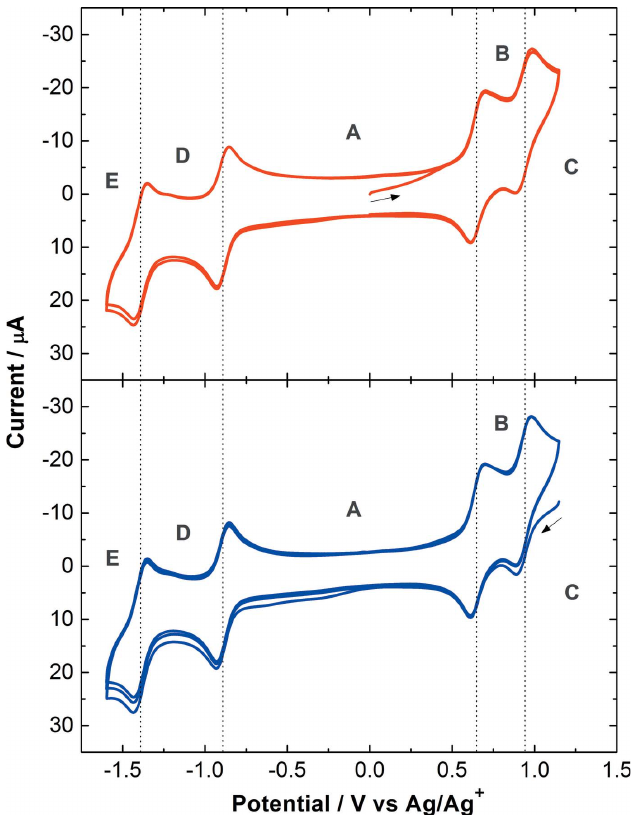
Figure 3 Cyclic voltammograms of 1.0 m M solutions of I in acetonitrile with 0.1 M Bu 4 NPF 6 as electrolyte. The various redox states are represented by the potential regions as A : [(bpy)(Cl)Ru II (tppz)Ru II (Cl)(bpy)] 2+ , B : [(bpy)- (Cl)Ru II (tppz)Ru III (Cl)(bpy)] 3+ ,